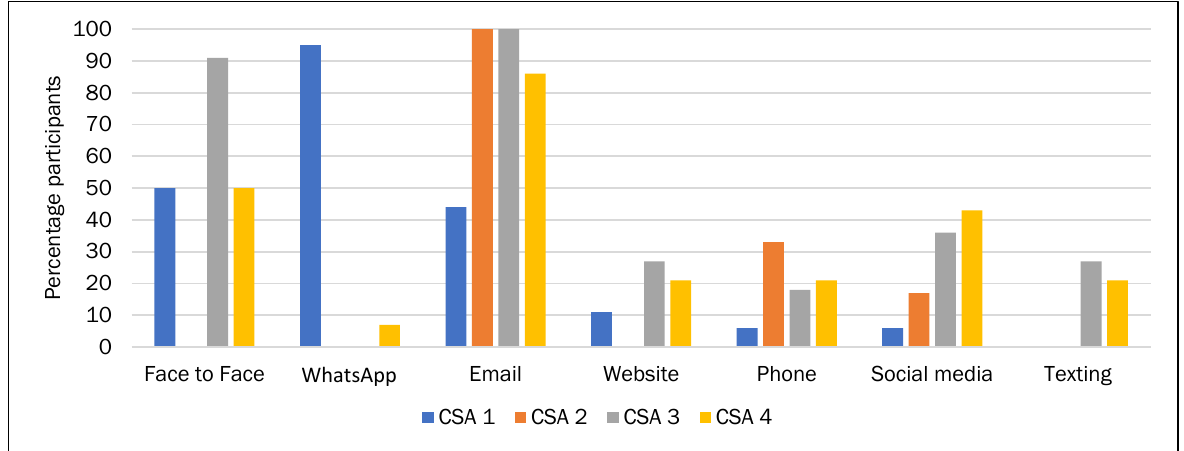
Figure 1. Percentage of Participants in Each CSA that Used the Communication Media